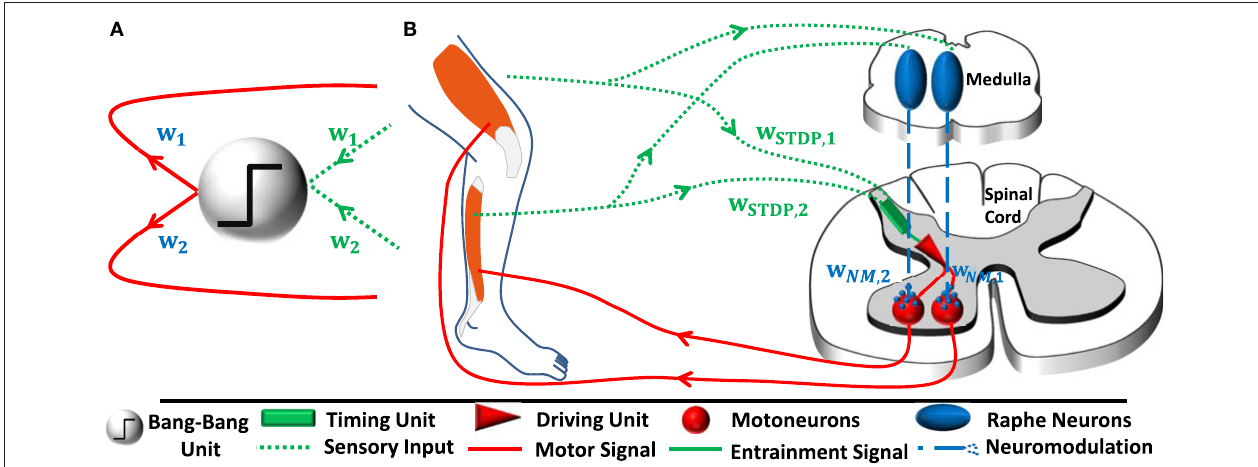
FIGURE 1 | (A) In the mathematical controller design as proposed by Lakatos et al. (2013b), sensory input from each joint i is transformed into a one-dimensional coordinate space. For this purpose, the sensory inputs are multiplied by weights w i . The input entrains a thresholding bang-bang unit, which produces a motor signal. The driving signal is transformed back into the original joint space via the same respective weights. The output transformation accomplishes correct relative force weighting of the individual joints (Figure based on Lakatos and Albu-Schäffer, 2014a). (B) In our hypothetical neural controller implementation, sensory input from the joints also converges. The synaptic weights w STDP , i change according to spike-timing-dependent plasticity. We emphasize that the bang-bang controller can be separated into two functionally distinct unit: A timing unit entrains a driving unit, which sends motor signals to muscles innervating all joints involved in a given periodic movement. While functionally distinct, these units do not have to be spatially separated in general. In our model, a single pool of reflex interneurons represents both units and outputs correctly timed motor signals. A parallel, joint-specific, sensory feedback pathway via raphe nuclei releases serotonin into motorpools. This amplifies the common motor output by w NM , i and increases the relative strength of muscles that are more involved in the